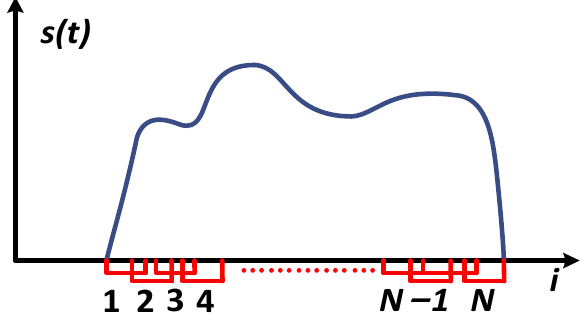
Figure 5. The split echo signal.